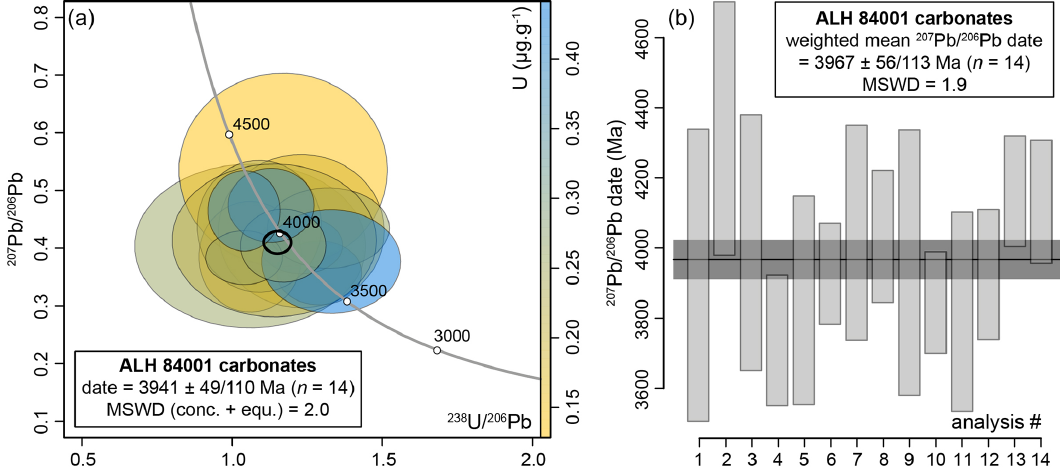
Figure 2. Tera–Wasserburg 207 Pb / 206 Pb vs. 238 U / 206 Pb diagram (a) and 207 Pb / 206 Pb dates (b) obtained on ALH 84001 carbonates. Ellipses (a) and error bars (b) correspond to 2 σ standard errors. The bold black ellipse in (a) corresponds to the calculated concordia date and associated